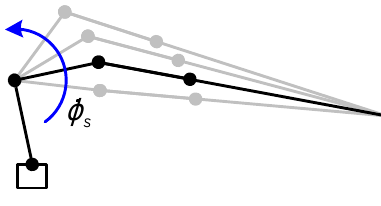
Figure 14: Configuration control (self motion).